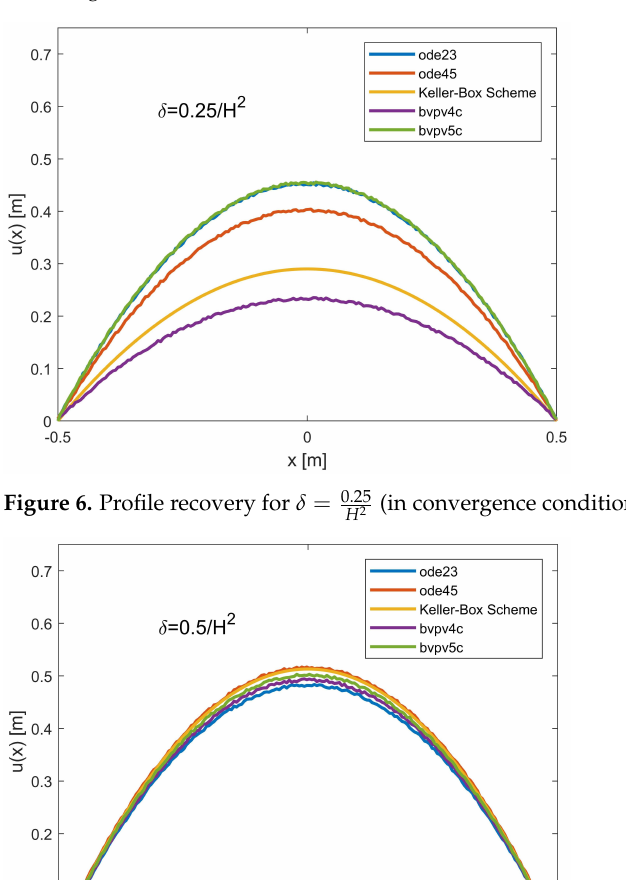
(in convergence conditions and without ghost H 2